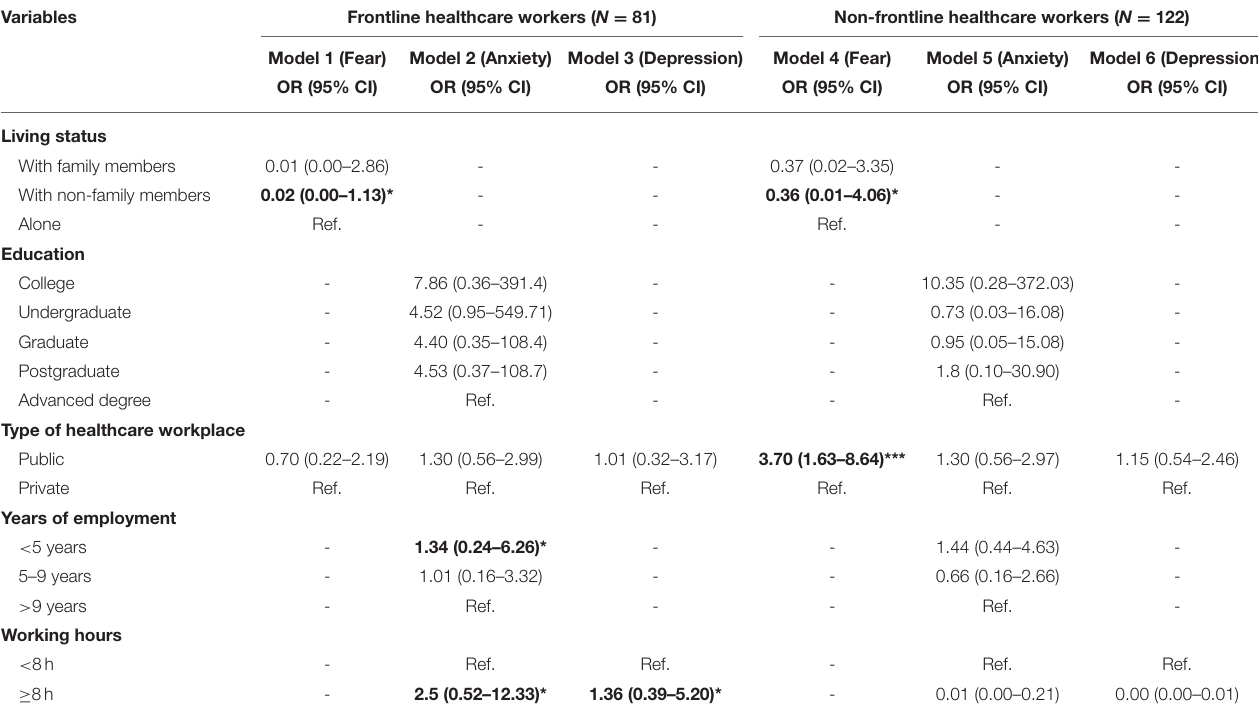
TABLE 4 | Regressing socio-demographic and work conditions on high levels of psychological distress (fear, anxiety, and depression) among Bangladeshi healthcare frontline and non-frontline workers.